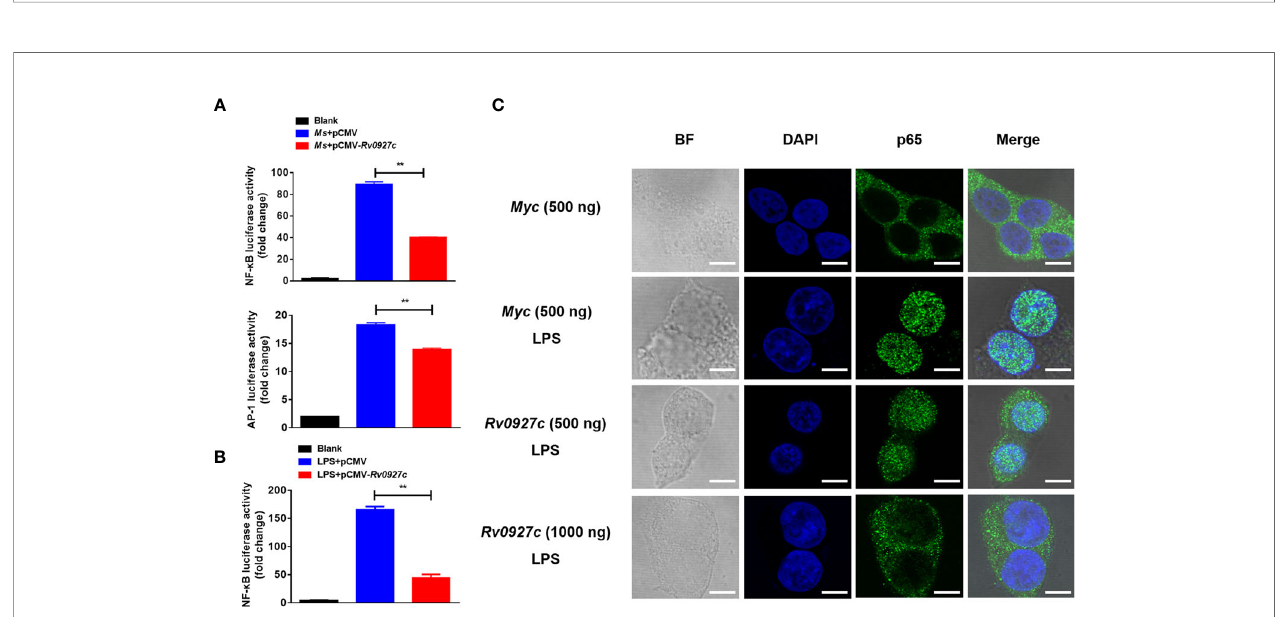
FIGURE 4 | Rv0927c suppresses luciferase activities of NF- k B and AP-1 and inhibits the LPS-induced nuclear translocation of p65. (A) RAW264.7 cells (2×10 5 cells/well) were transfected with NF- k B or AP-1 reporter plasmid (250 ng) and pRL-TK control (10 ng), as well as plasmids encoding Myc (250 ng) or Rv0927c (250 ng). After infection with M. smegmatis , cells were collected to determine the luciferase activities by Dual-Luciferase ® Reporter Assay System. (B) HEK293- TLR4 cells (2×10 5 cells/well) were transfected with pCMV- Myc (250 ng) or pCMV- Rv0927c (250 ng) and NF- k B promoter luciferase reporter constructs (250 ng), as well as plasmid pRL-TK (10 ng). After stimulation with LPS (100 ng/ml) for 5 h, cells were harvested to measure the luminescence. (C) HEK293-TLR4 cells were transfected with Rv0927c or empty vector. The translocation of p65 was observed using a fl uorescence microscope after LPS stimulation for 0.25 h Scale bars, 5 m m. ** P < 0.01 (unpaired two-tailed Student ’ s t test). Data are representative of experiments with at least three independent biological replicates (mean and sem of n = 3